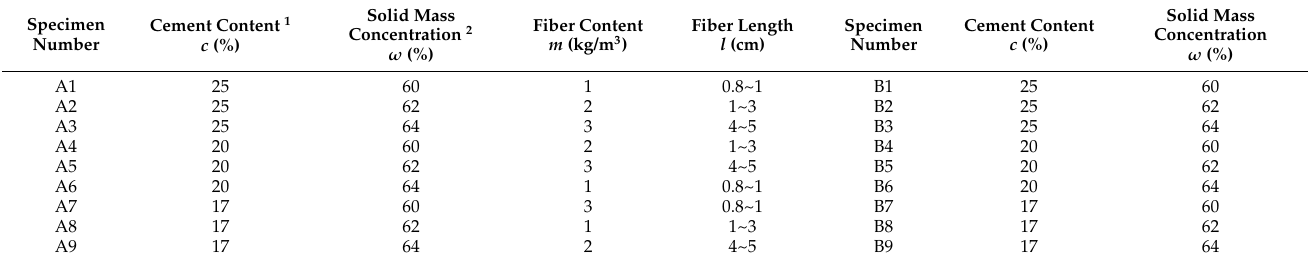
Table 4. Orthogonal table L 9 (3 4 ) of all manufactured mixtures.